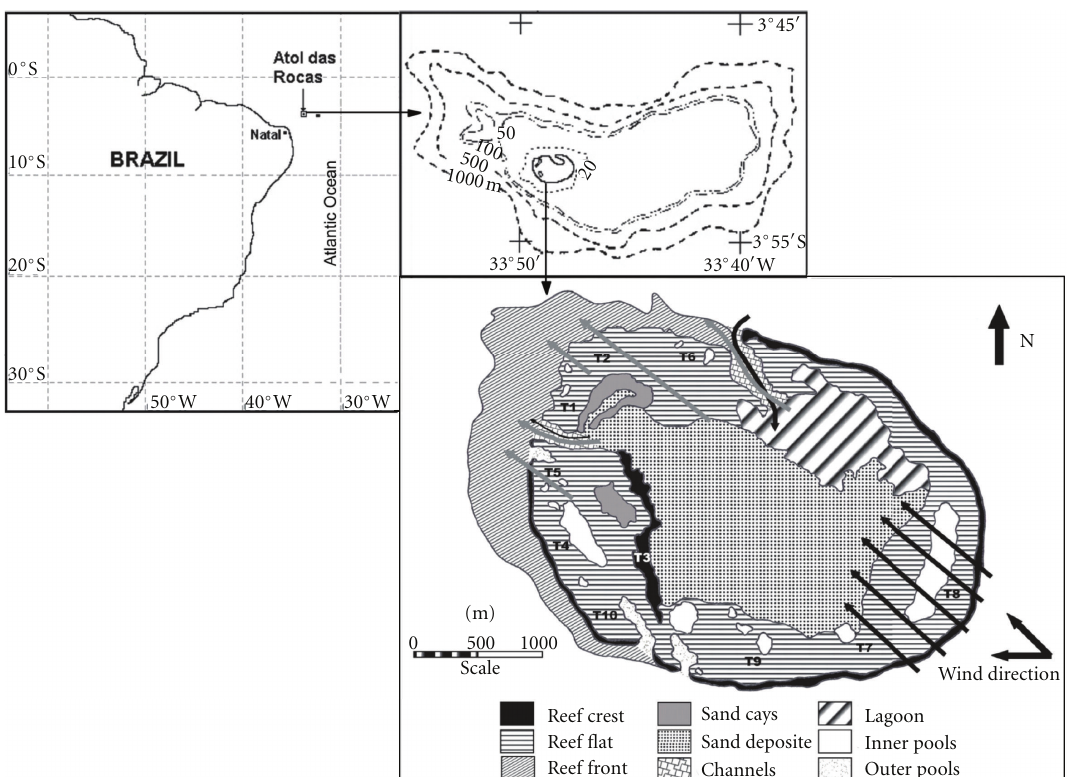
Figure 1: Study area showing the sampling sites on the reef flat (T1–T10) and the pattern of internal current circulation: black arrows = flood tide, gray arrows = ebb